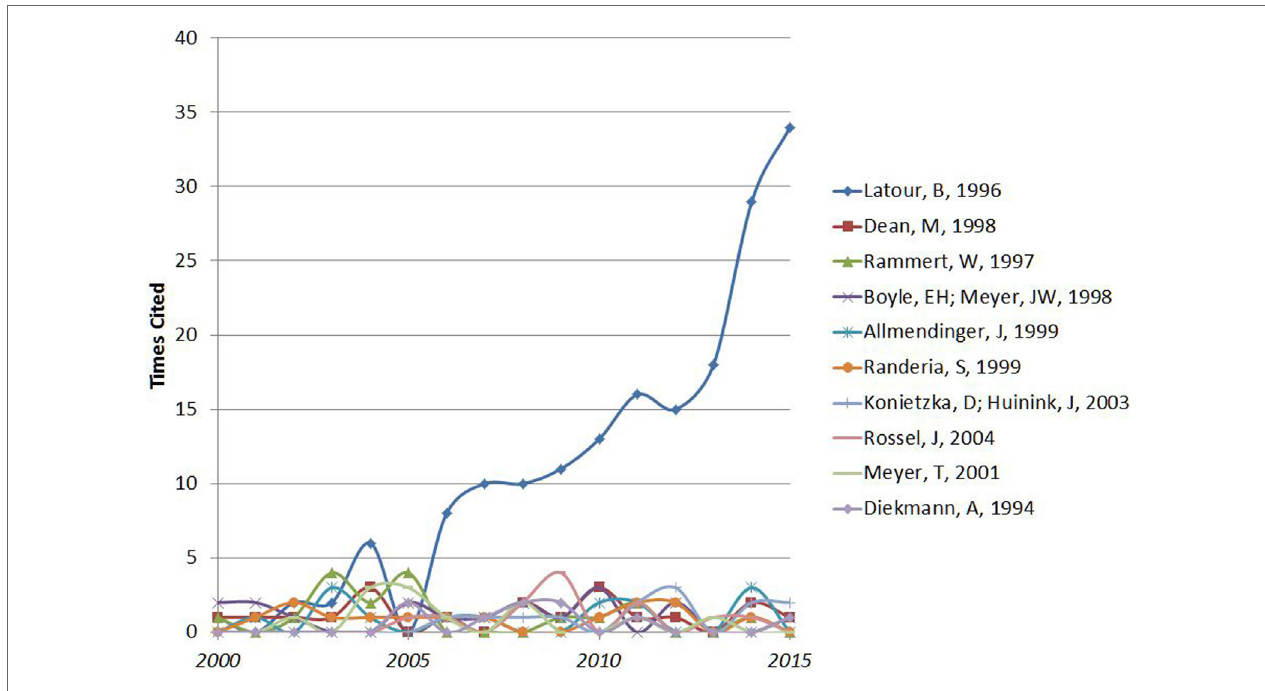
FigUre 2 | Ten most-cited papers in Soziale Welt (14 February 2016) .